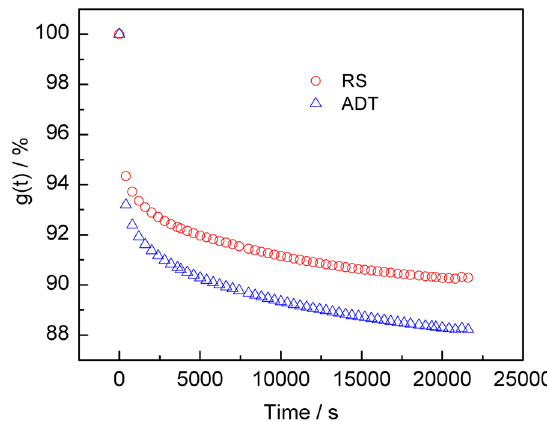
Figure 6: Normalized stress relaxation modulus for 2 - week exposure samples at 70°C.